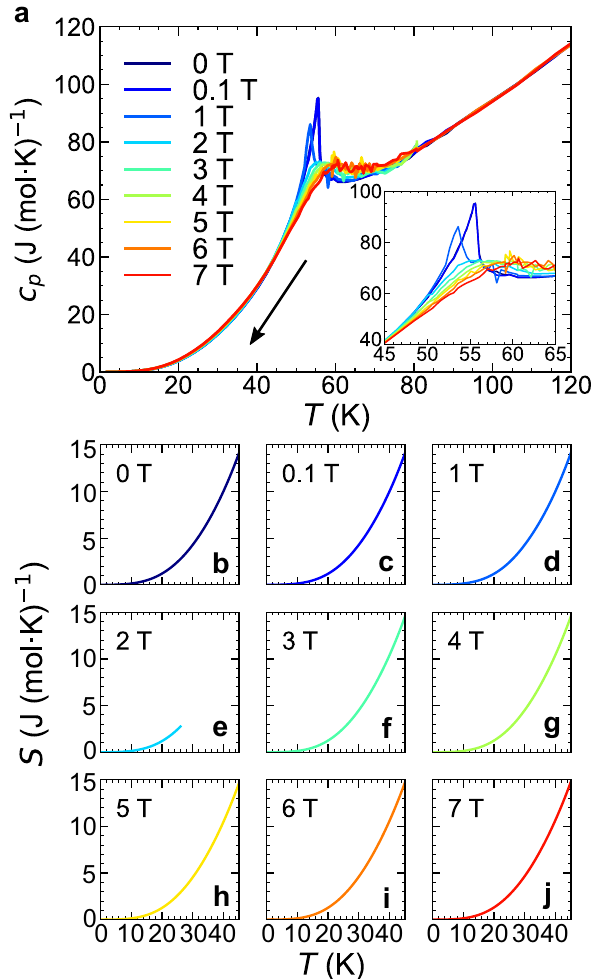
Figure 3. Temperature dependences of the specific heats and entropies under magnetic fields. ( a ) Temperature dependencies of the specific heats under various magnetic fields. The specific heat measurement was performed during the field-cooling process. Inset: Enlarged view around the transitions. The c p ( T ) at 0 and 0.1 T are almost identical and no difference is distinguishable on this scale. ( b–j ) The temperature dependencies of the entropies under various magnetic